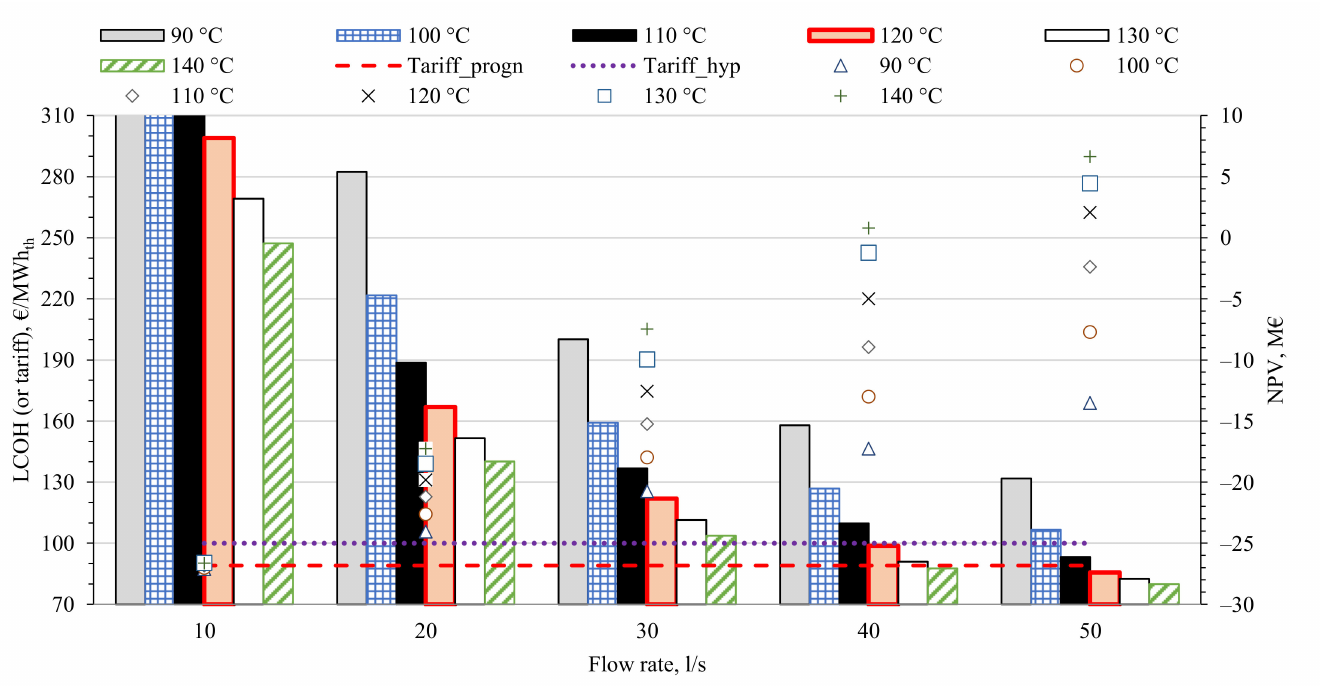
Figure 6. LCOH (columns), prognosed heat tariff for the campus (dashed line), hypothetic heat tariff for the campus if CO 2 tax is 100 € /t (dotted line), and NPV (symbols) for the reference case. Note: the values of LCOH for 90 ◦ C, 100 ◦ C and 110 ◦ C under 10 l/s are 525, 406 and 342 € /MWh th ,